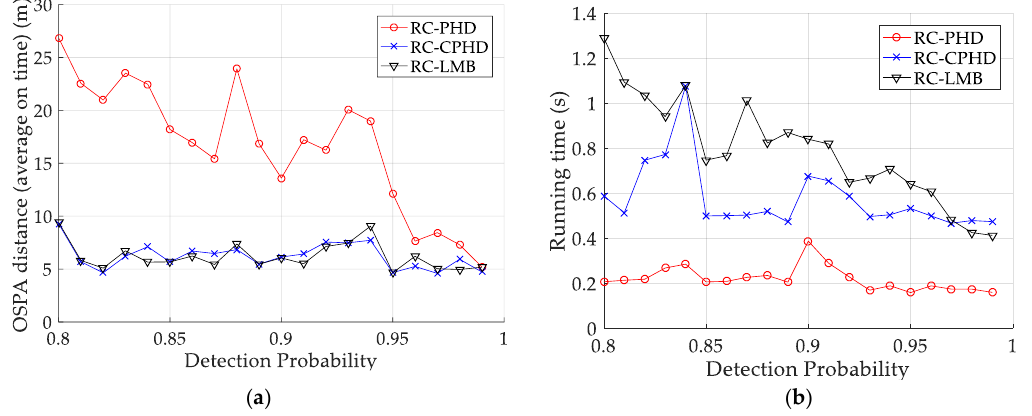
Figure 12. Comparison of tracking performance versus clutter rate for a target on a curved road: ( a ) average OSPA of the tracking algorithms; ( b ) running time of the tracking algorithms.